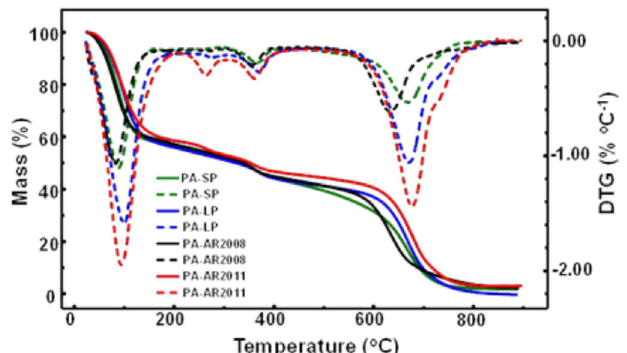
FIGURE 2 - TG/DTG curves obtained at 10 °C min –1 under a dynamic air atmosphere for the samples: phytic acid as received